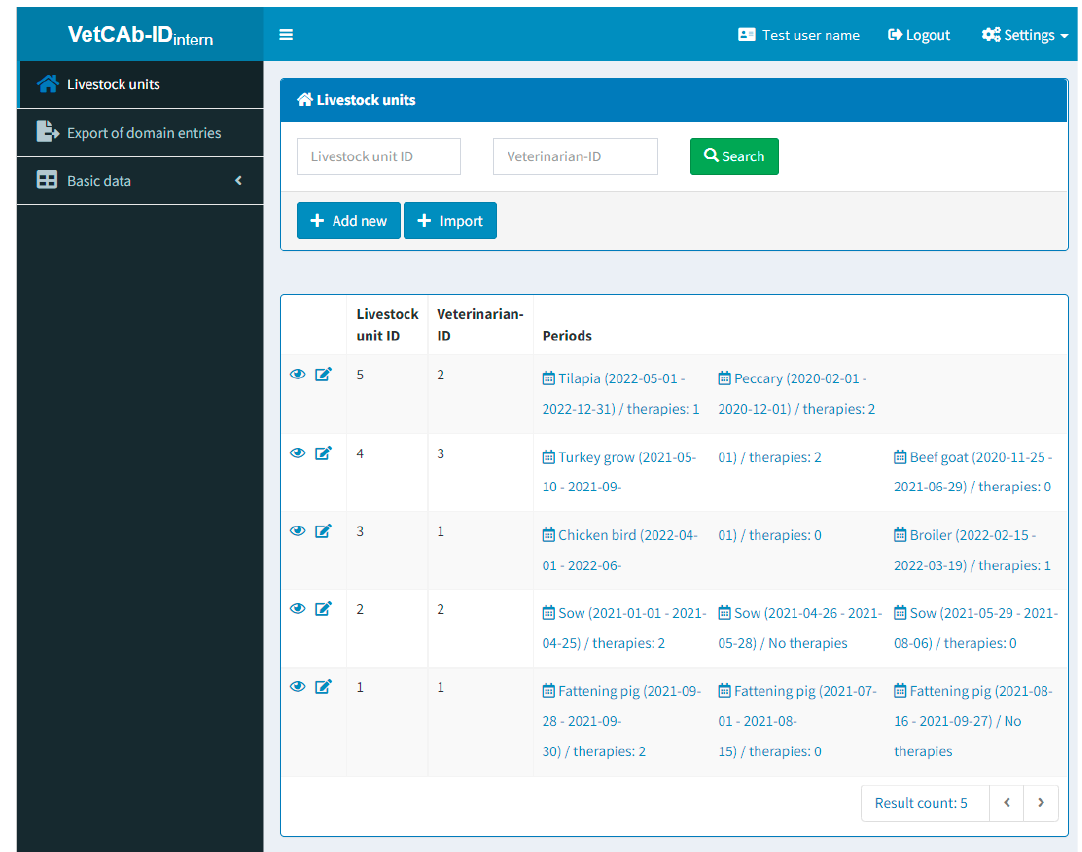
Figure 1. Overview of entries by test user in the VetCAb-ID database.